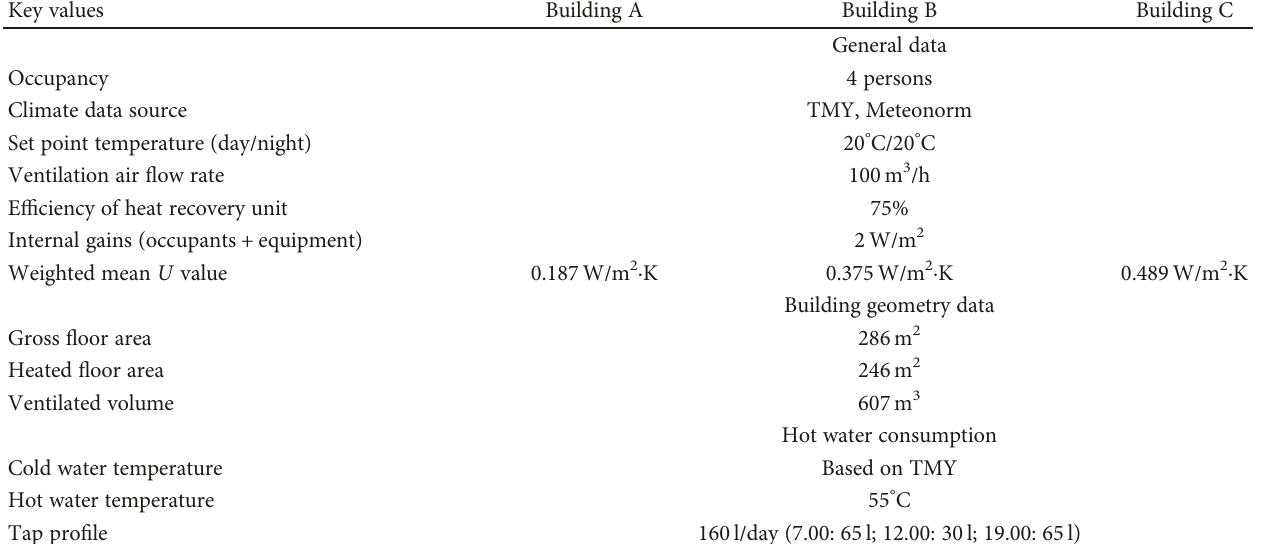
Table 2: Main parameters of buildings in the analysis.